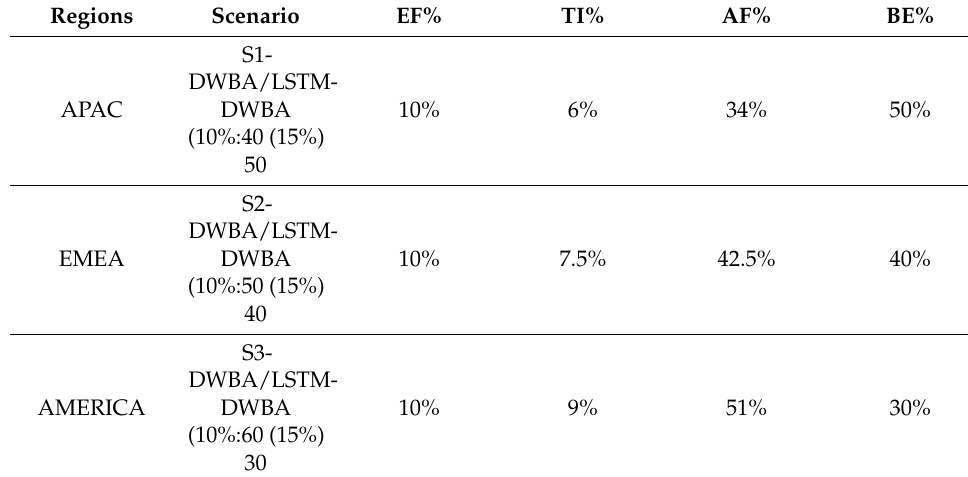
Table 2. Simulation